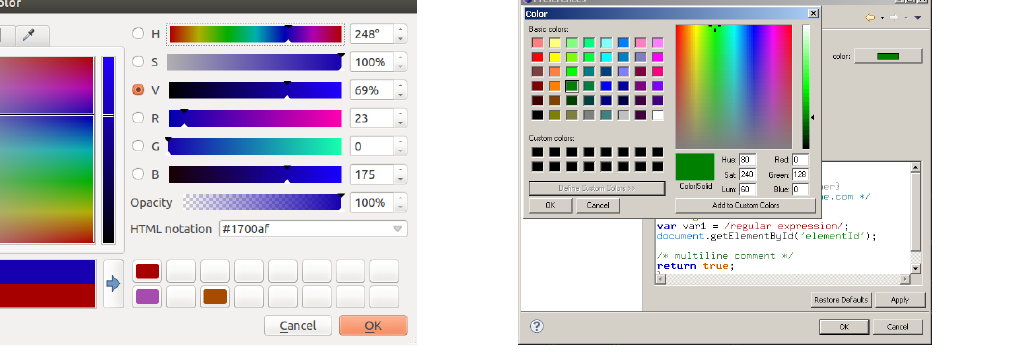
Figure 1 – One community’s colour picker Figure 2 – The Windows colour